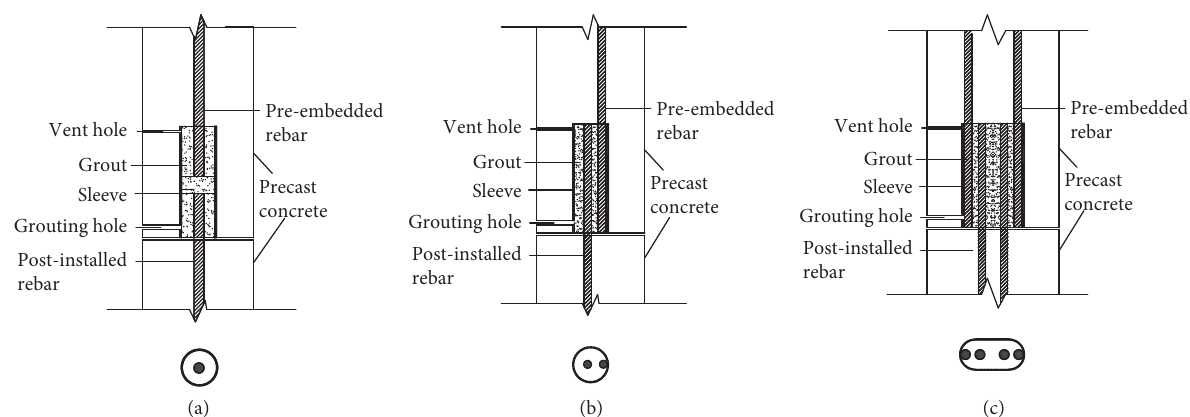
Figure 1: Forms of grouted connectors for reinforcement bars. (a) Grouted splice connector. (b) Type-I grouted sleeve lapping connector. (c) Type-II grouted sleeve lapping